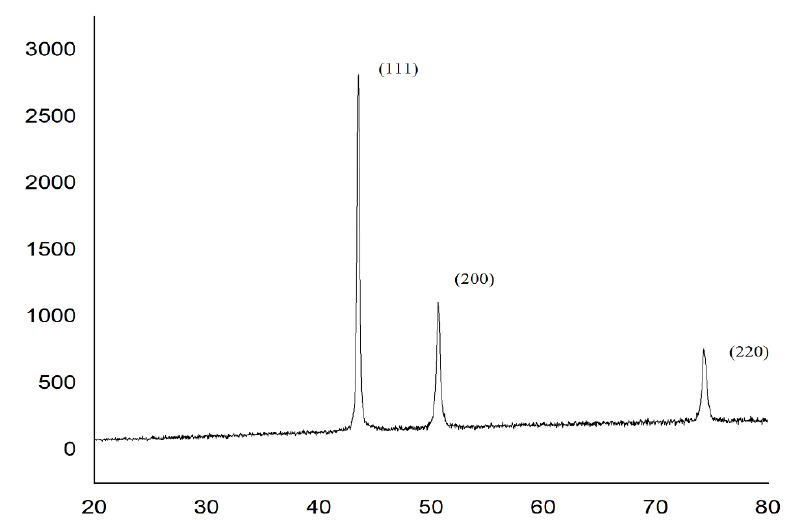
Figure 7. The XRD pattern of synthesis of Cu particles.